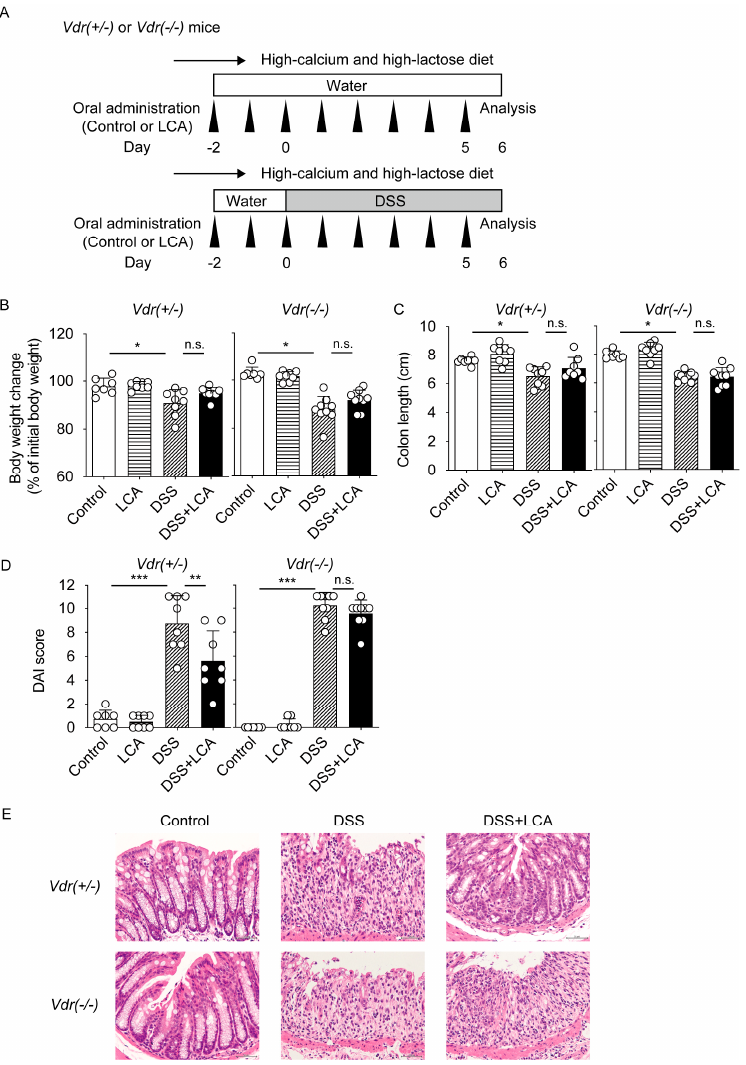
Figure 3. Effects of oral administration of LCA on DSS-induced colitis in Vdr(+/ − ) and Vdr( − / − ) mice. ( A ) Experimental procedure for oral administration of LCA and DSS treatment in Vdr(+/ − ) and Vdr( − / − ) mice. Mice were raised on a high-calcium and high-lactose diet. Mice were administered control corn oil or LCA (in corn oil) from day − 2 to day 5, were treated with or without 2% DSS from day 0 to 6, and were subjected to analysis at day 6. n = 8–10 for each group. ( B ) Body weight change. ( C ) Colon length. ( D ) DAI score. Data are presented as means ± S.D. * p < 0.05; ** p < 0.01; *** p < 0.001; n.s., not significant (one-way ANOVA followed by Tukey’s multiple comparisons). ( E ) Histology with hematoxylin and eosin staining. Scale bar, 50 µ m. Original magnification 400 ×